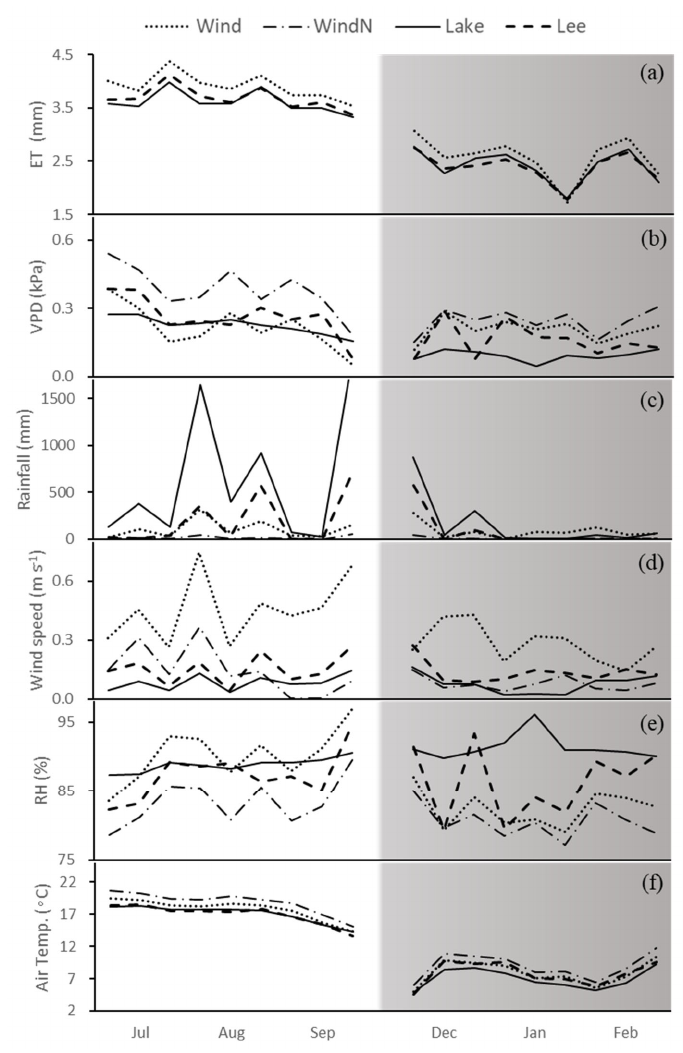
Figure 3. Ten days mean canopy microclimate recorded at the four sites in 2019 summer and 2019– 2020 winter (shaded area): ( a ) ET, evapotranspiration; ( b ) VPD, vapor pressure deficit; ( c ) rainfall; ( d ) wind speed; ( e ) RH, relative humidity; ( f ) air temperature.